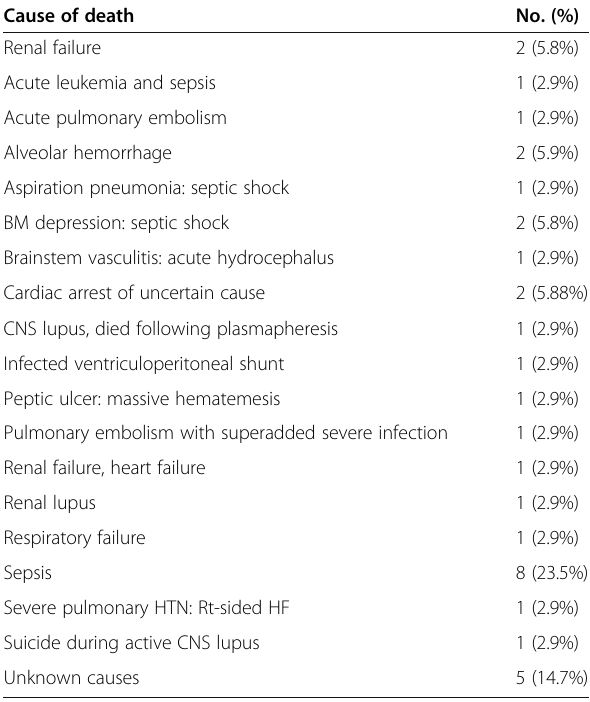
Table 1 Distribution of the studied cases according to cause